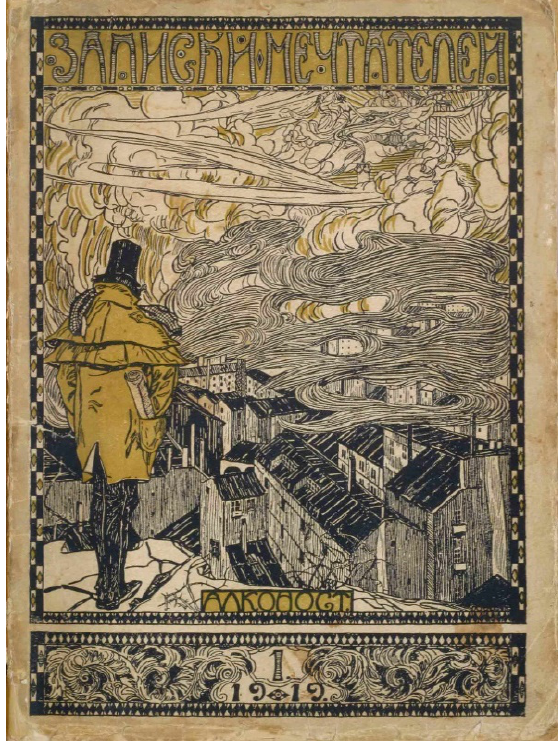
Figure 1. Journal Dreamers’ Notes (1919–1922). Cover by A.Y.